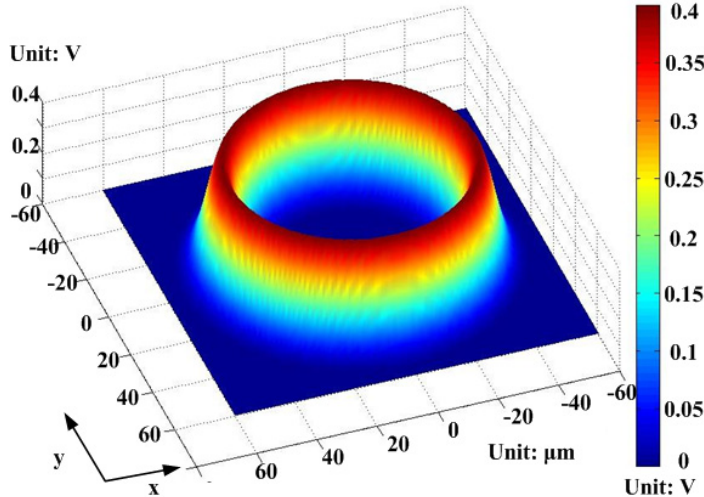
Figure 6. Simulated potential voltage distribution for the “light trap” used in our experiments as the virtual